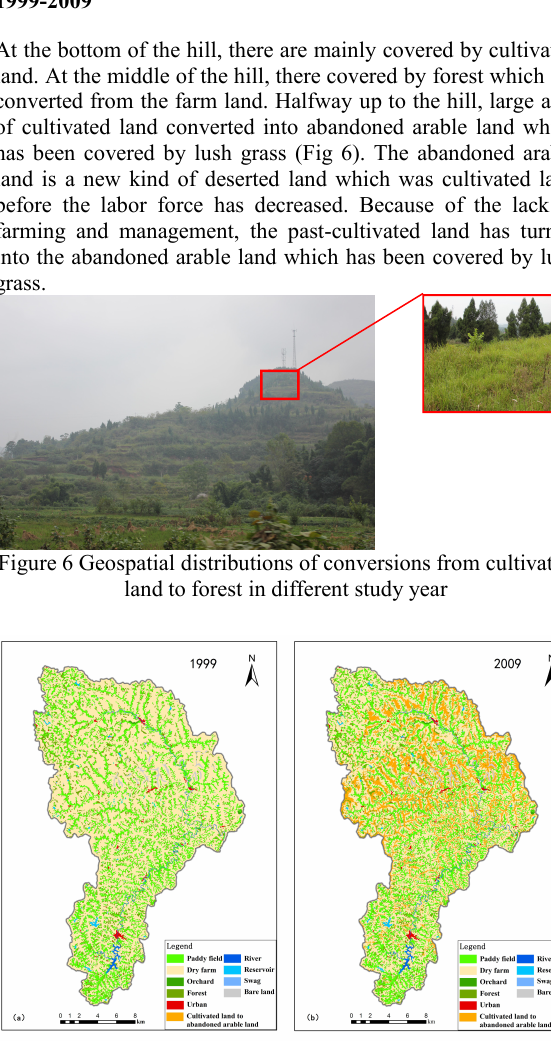
Figure 7 Geospatial distributions of conversions from cultivated land to abandoned arable land in different study year